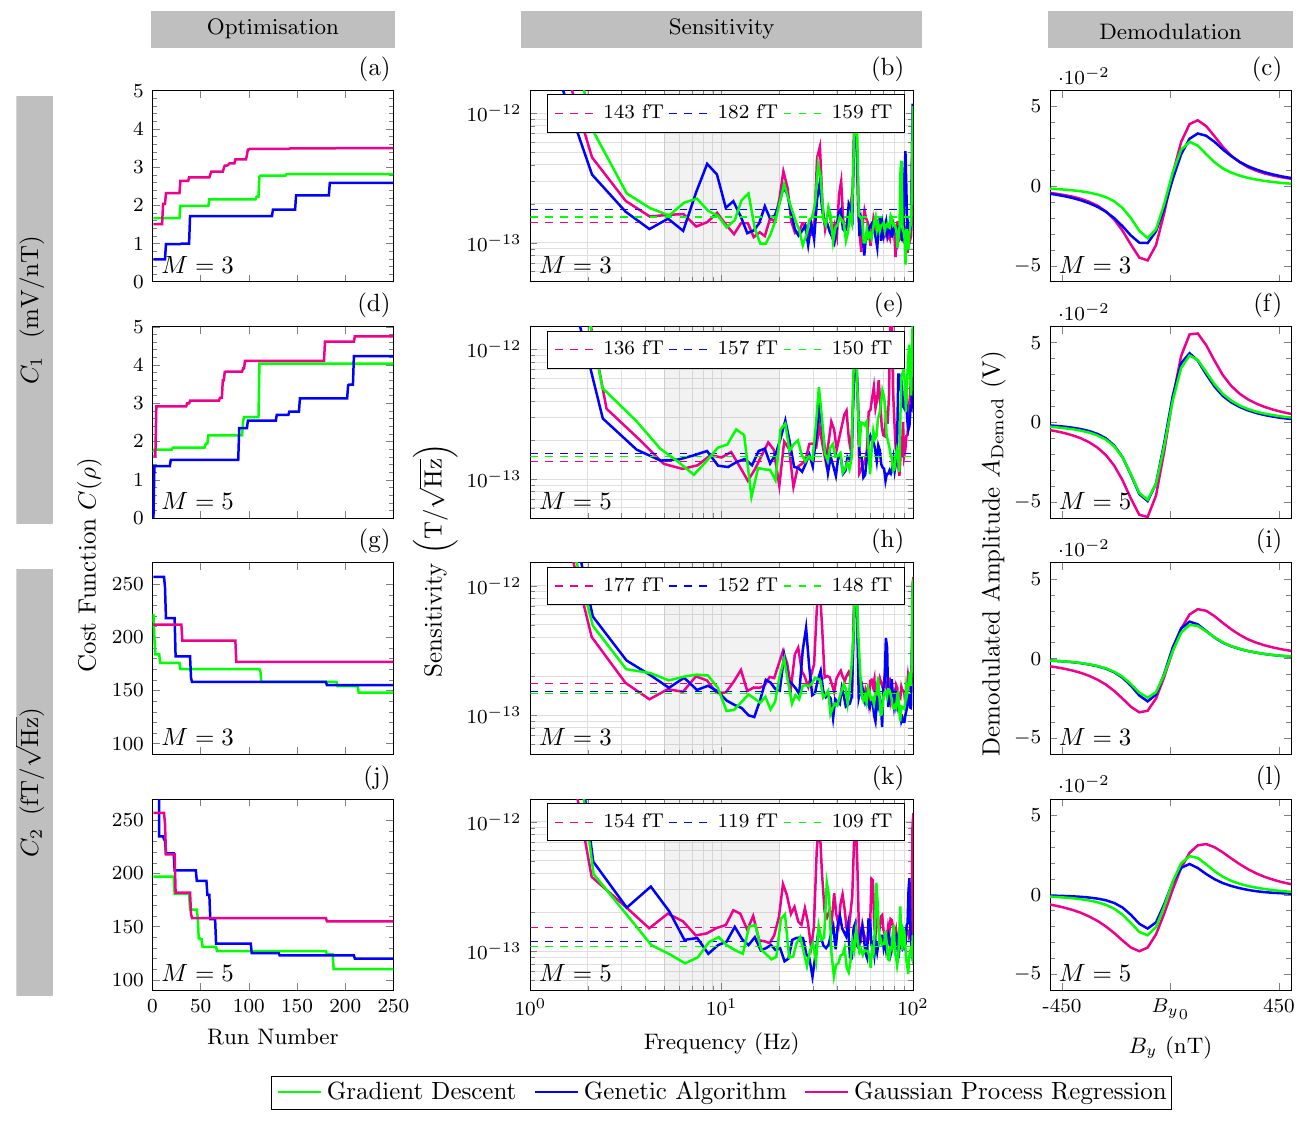
Figure 5. All figure parts contain the following optimisation techniques, gradient descent algorithm in green , genetic algorithm in blue and Gaussian process regression model in pink. M , the number of parameters optimised. Row 1 & 3, ( a–c,g–i ), optimisation of 3 parameters ( M = 3). Row 2 & 4, ( d–f,j–l ) optimisation of 5 parameters ( M = 5). Row 1 & 2, ( a–f ), optimise for maximising cost function C 1 the demodulated line shape gradient (mV/nT). Row 3 & 4, ( g–l ), optimise for minimising cost function C 2 , calculated sensitivity (T/ √ Hz). Column 1 “Optimisation”, ( a,d,g,j ), show Cost function as a function of run number. The solid line indicates the moving maximum per optimisation technique. Column 2 “Sensitivity”, ( b,e,h,k ), shows corresponding FFT for the optimal parameters found per optimisation technique. Sensitivity is shown as a function frequency (Hz), raw data are shown by solid lines. The frequency band of interest (5 to 20 Hz) is highlighted in grey. Averaged sensitivity in this band is shown by the dashed line (value represented in the key). Column 3, “Demodulation”, ( c,f,i,l ), shows a corresponding demodulated line shape for the optimal parameters found per optimisation